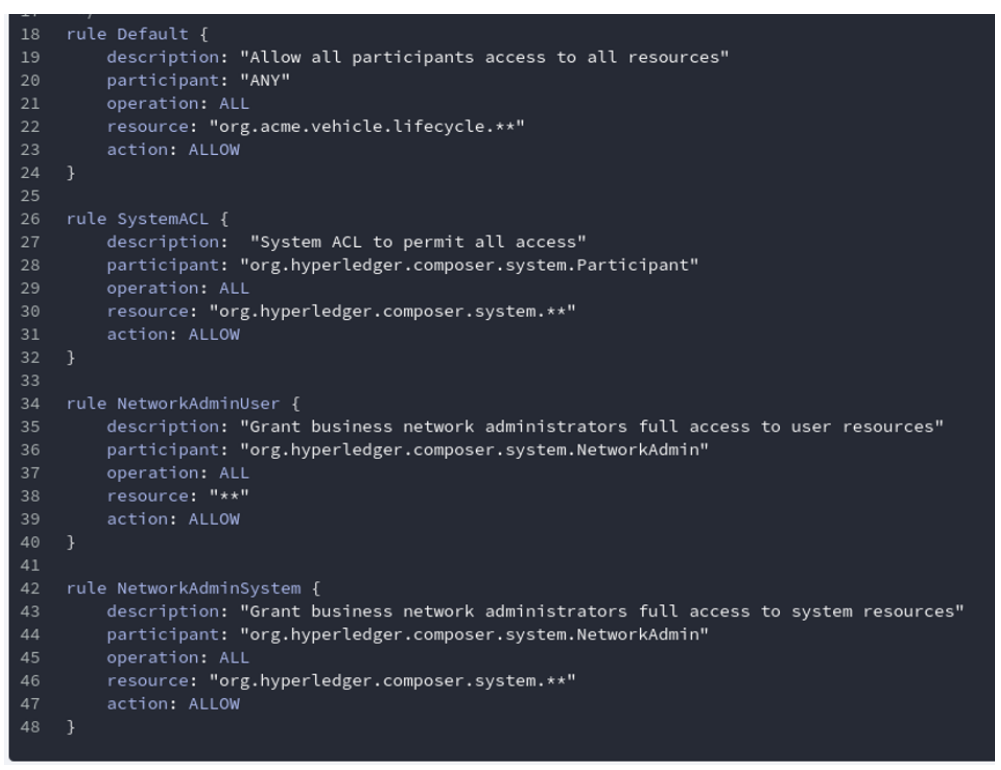
Figure 10. Control policy defined in smart